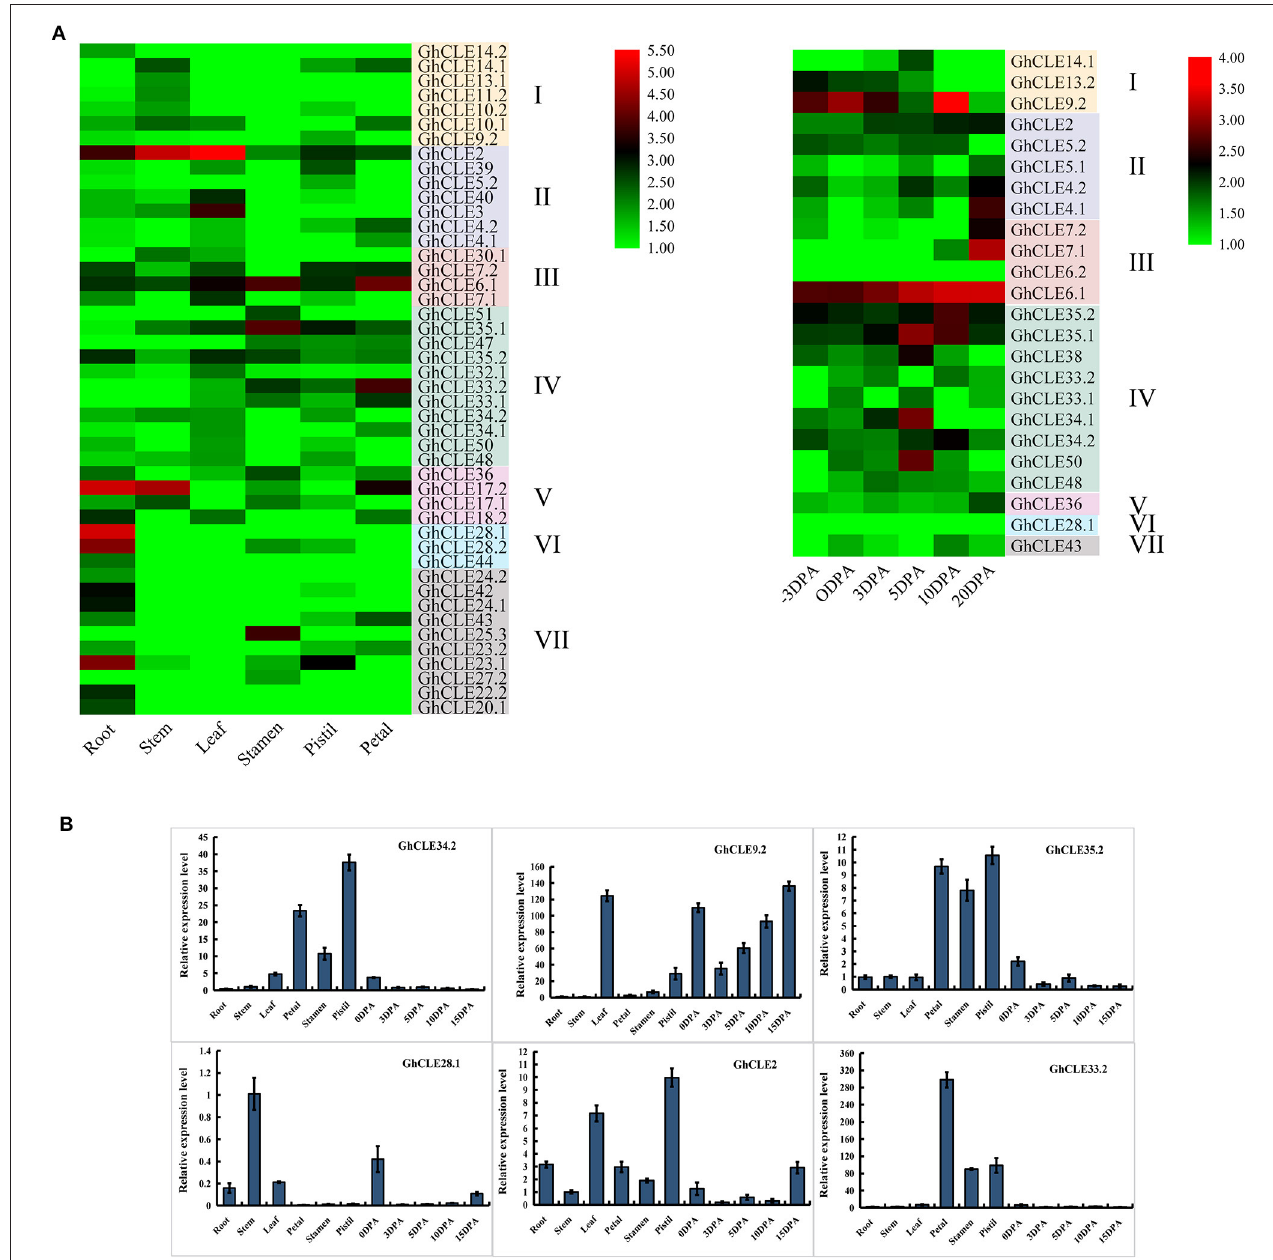
FIGURE 5 | Expression patterns of GhCLEs in different tissues. (A) Tissue/organ-specific expression patterns of GhCLEs , including root, stem, leaf, petal, pistil, stamen, and ovule ( − 3, 0, 3, 5, 10, 20 DPA). Heat map was drawn according to calculation results of log 2 of fragments per kilobase million (FPKM) RNA sequencing (RNA-seq) data. (B) Relative expression levels of six GhCLE genes in different tissues.